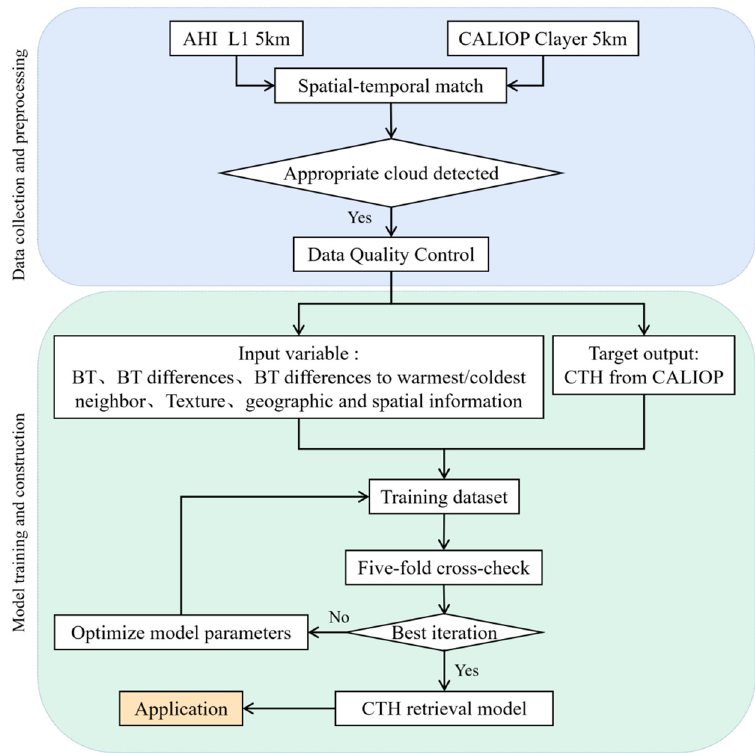
Figure 3. Model training process based on XGBoost.